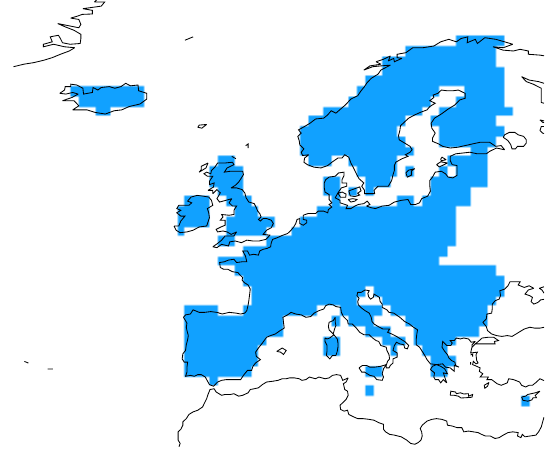
Fig. 1. Spatial extent of the region under study including: Alba- nia (ALB), Austria (AUT), Belgium (BEL), Bosnia and Herzegov- ina (BIH), Bulgaria (BGR), Croatia (HRV), Cyprus (CYP), Czech Republic (CZE), Denmark (DNK), Estonia (EST), Finland (FIN), France (FRA), Germany (DEU), Greece (GRC), Hungary (HUN), Iceland (ISL), Ireland (IRL), Italy (ITA), Kosovo (UNK), Latvia (LVA), Lithuania (LTU), Luxembourg (LUX), Macedonia (MKD), Malta (MLT), the Netherlands (NLD), Norway (NOR), Poland (POL), Portugal (PRT), Romania (ROU), Serbia and Montenegro (SCG), Slovakia (SVK), Slovenia (SVN), Spain (ESP), Sweden (SWE), Switzerland (CHE) and United Kingdom